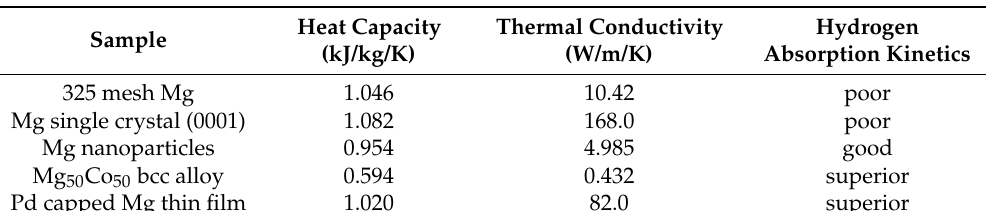
Table 4. Thermal and kinetic properties of several types of Mg-based materials. Reprinted with the permission from [78], Copyright Elsevier, 2014.